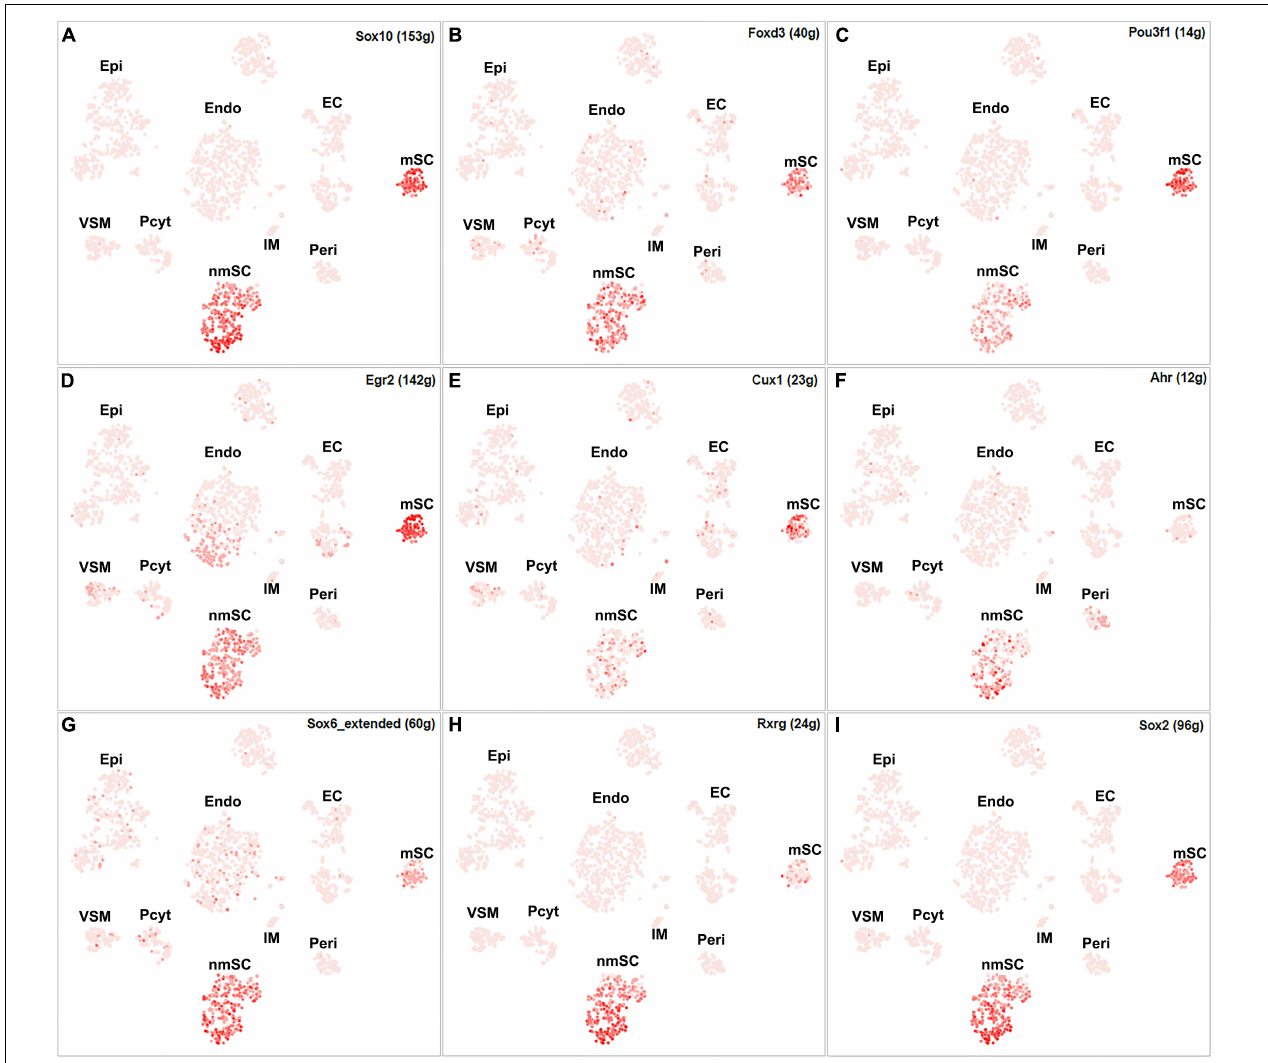
FIGURE 4 | tSNE showing regulon activity for TFs in mSCs and nmSCs. (A) Sox10, (B) Foxd3, (C) Pou3f1, (D) Egr2, (E) Cux1, (F) Ahr, (G) Sox6, (H) Rxrg and (I) Sox2.